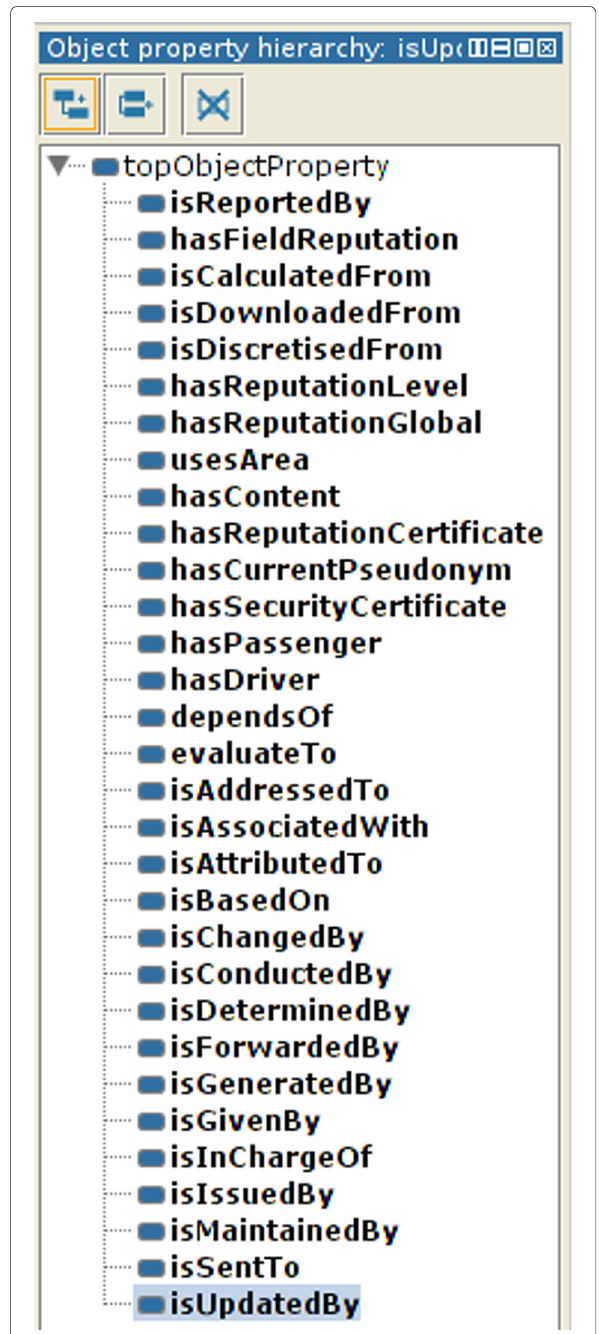
vehicle enables the unfriendly configuration. Then, the vehicle schedules the forwarding of ACM to the neighbors of one hop and returns to the listening state.